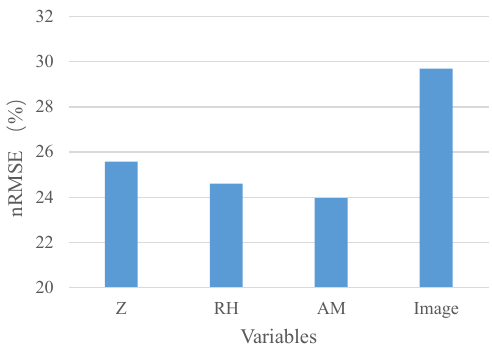
Figure 6. The nRMSE of the proposed method without the horizontal axis variable, where Z means solar zenith angle, RH means relative humidity, AM means air mess and image means total sky image.